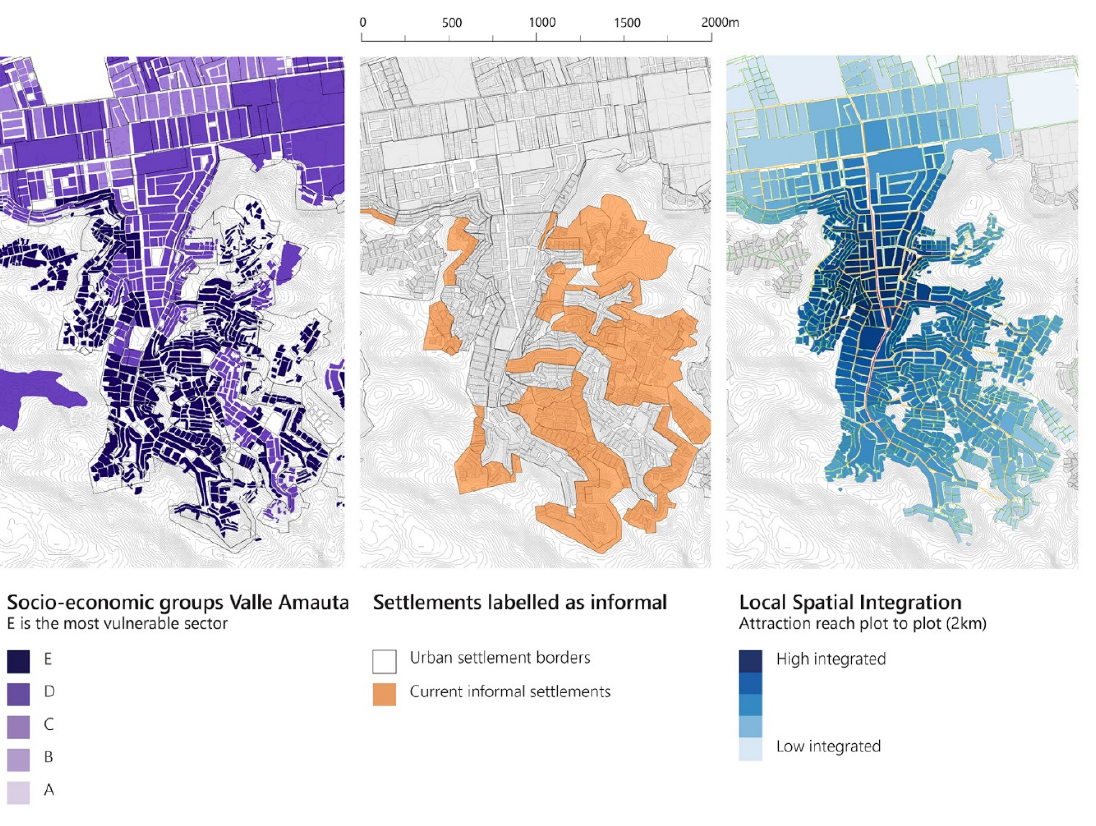
Figure 4. Socio-spatial segregation and urban informality in Valle Amauta. Source: Authors, based on data from INE (2016), Municipality of Ate (2016) and Municipality of Lima